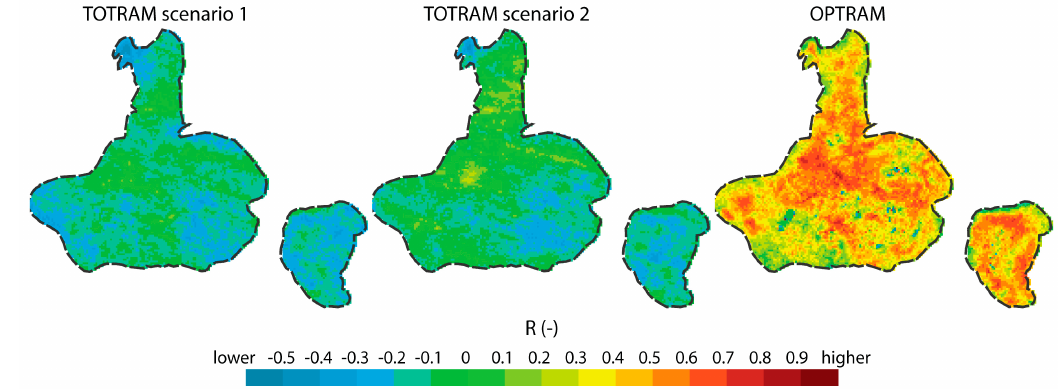
Figure 8. The long-term per-pixel temporal correlation coefficient (R) estimated for the mean water table depth from all eight monitoring wells and soil moisture indices derived from TOTRAM Scenario 1, TOTRAM Scenario 2, and OPTRAM.